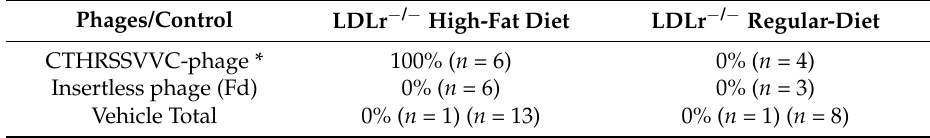
Figure 7. CTHRSSVVC-phage to Regular ( A ) and High-Fat diet ( B ); and insertless phage to regular ( C ) and High-Fat diet ( D ); homing specificity to organ target. Representative sections of mice aortic root from Regular ( n = 8) and High-Fat diet ( n = 13) groups. Hematoxylin–eosin (HE) staining to aorta was performed to all groups. High-Fat diet group presented a strong positively stained area as indicated by the star ( * ) to CTHRSSVVC-phage homing ( B ) and negative to insertless Fd-tet phage on the same diet ( D ). The CTHRSSVVC-phage bound quantification in atheroma of High-Fat diet mice ( B ) was reported as means ± SEM 45.50, ± S.D 13.97 and all other sections were negative to phage homing. As a reaction control, primary antibody was omitted. Bar, 20 µ m in all panels. Table 4. Phage homing to atherosclerotic lesions at aortic root of LDLr − / − mice.